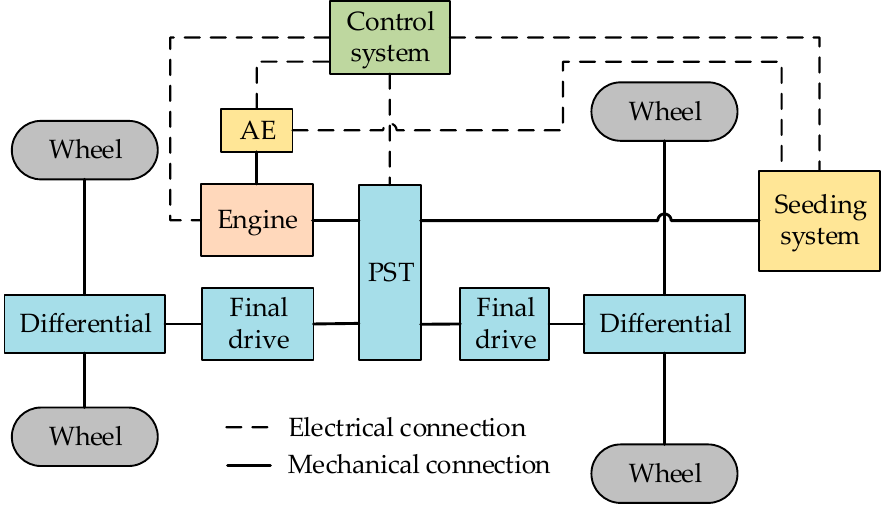
Figure 3. Powertrain diagram of tractor-planter combination operating unit.